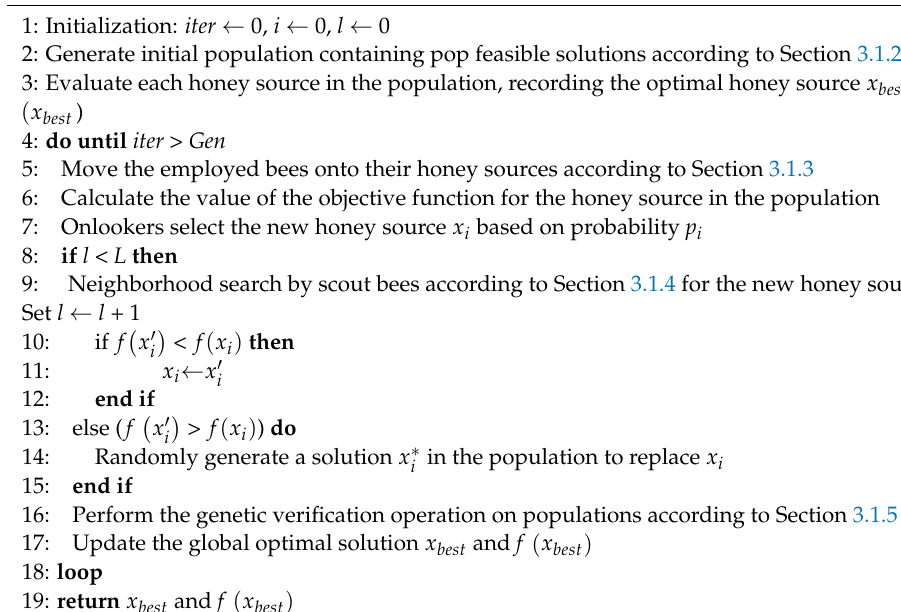
Algorithm 1 IABC Algorithm Pseudocode